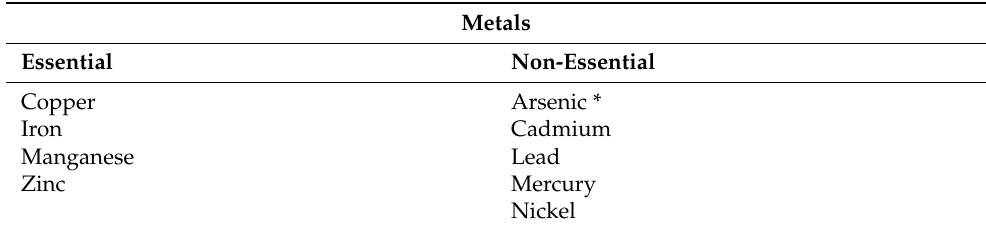
Table 1. Neurotoxic metals and metalloid